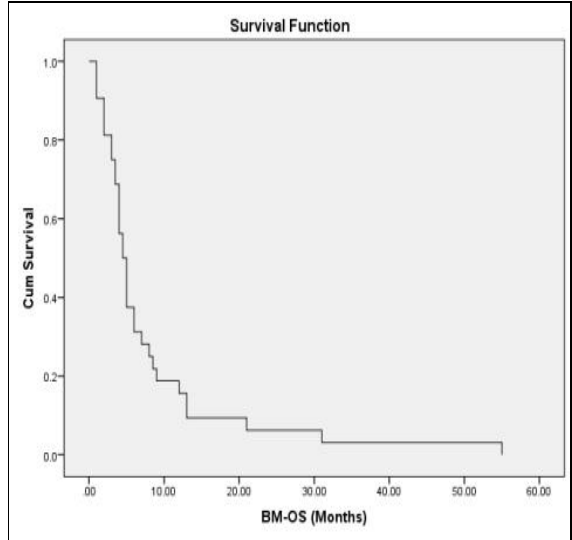
Figure 1: Progression free survival curve of 32 patients with brain metastases